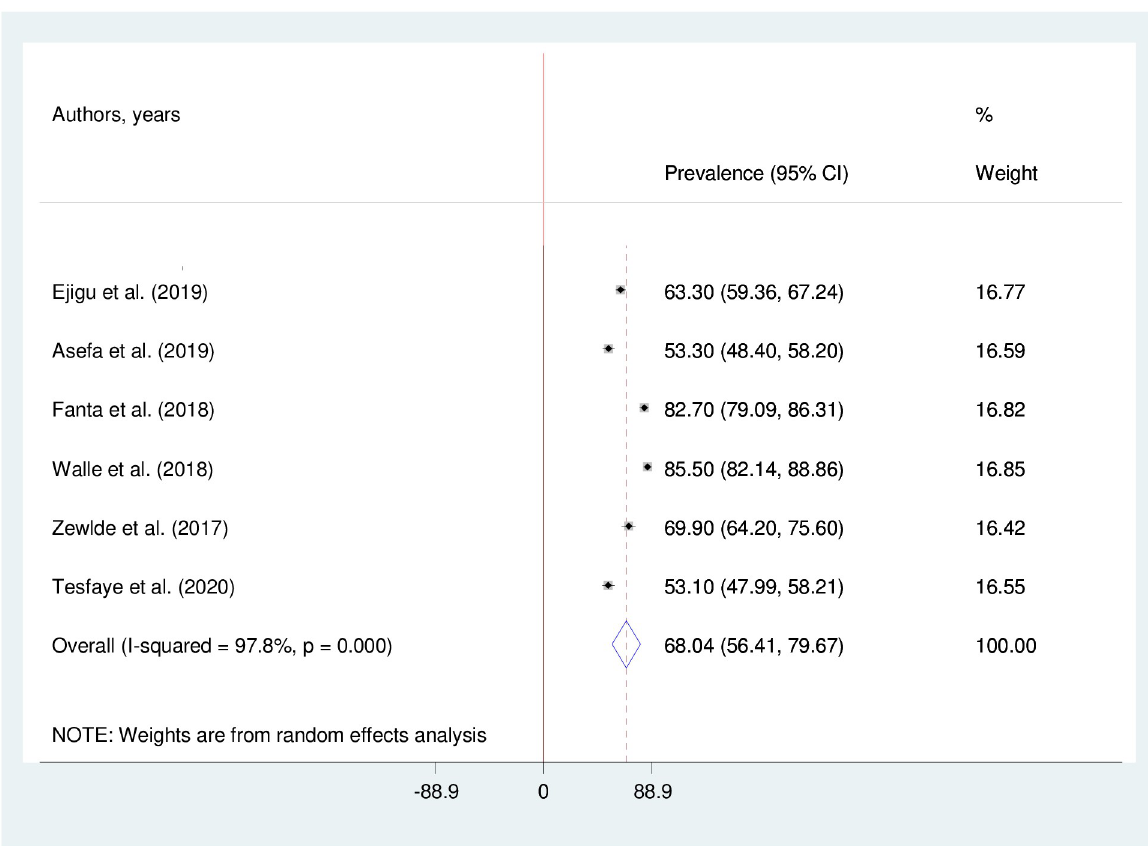
Fig 2. The pooled prevalence of sexual dysfunction in patients with non-communicable disease in Ethiopia.